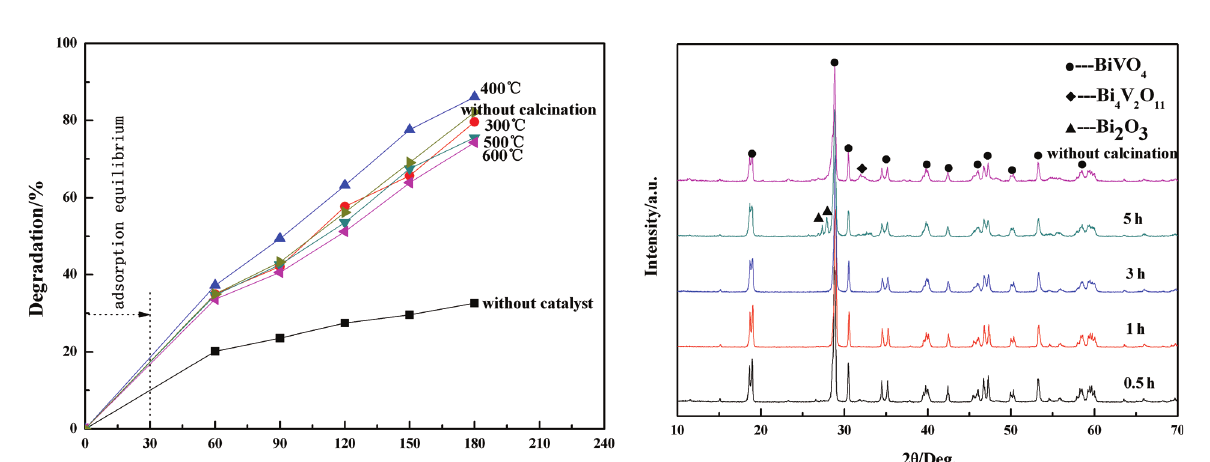
Figure 2: SEM pictures of BiVO 4 with dif- ferent heat treatment temperatures